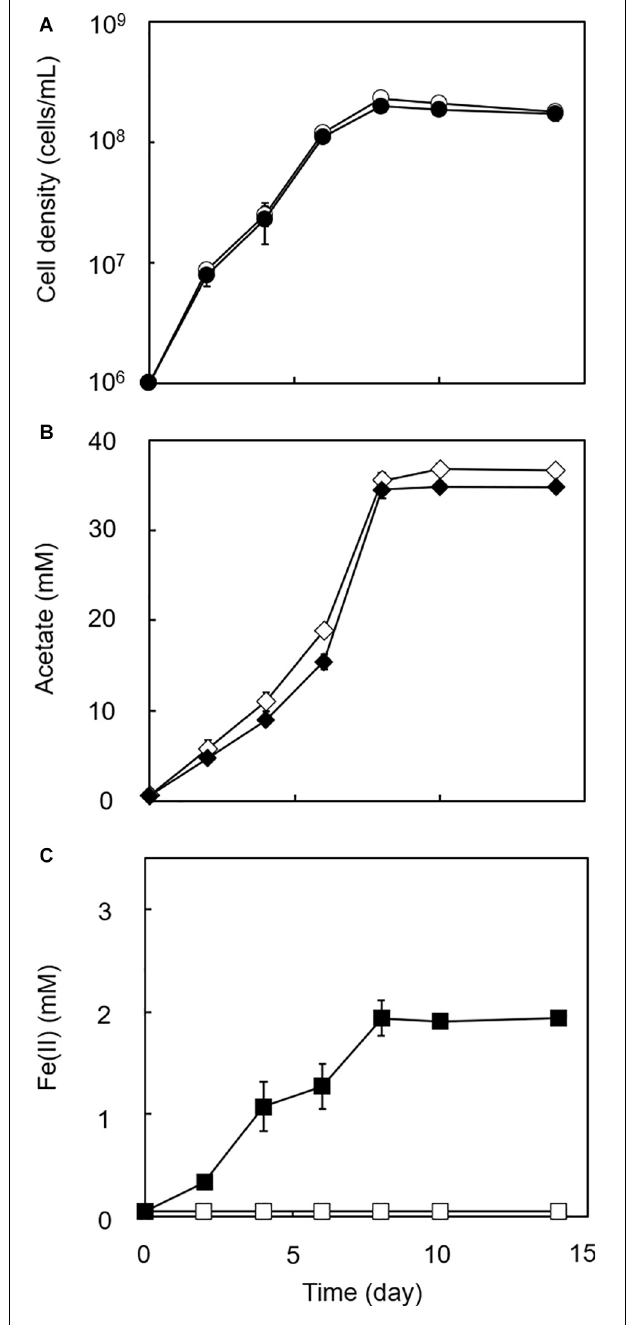
FIGURE 4 | Growth dependent HFO reduction by strain GT1 under lithotrophic condition. Strain GT1 was cultivated on H 2 + CO 2 (80:20) in the presence or absence of HFO. (A) Cell density, (B) concentration of acetate, and (C) Fe(II) concentration were periodically determined during cultivation. Closed symbols, cultures with HFO. Open symbols, cultures without HFO. Data are presented as the means of three independent cultures, and error bars represent standard